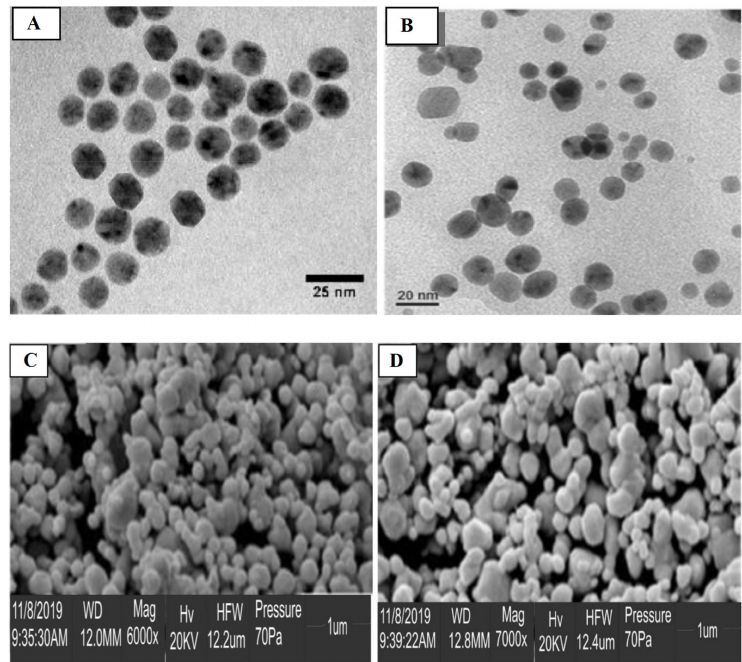
Figure 4. Characterization of AgNPs and AuNPs synthesized from Crassocephalum rubens leaf extract. TEM images of ( A ) AgNPs and ( B ) AuNPs; SEM images of ( C ) AgNPs and ( D ) AuNPs. Reprinted with permission from Reference [44].Copyright 2021